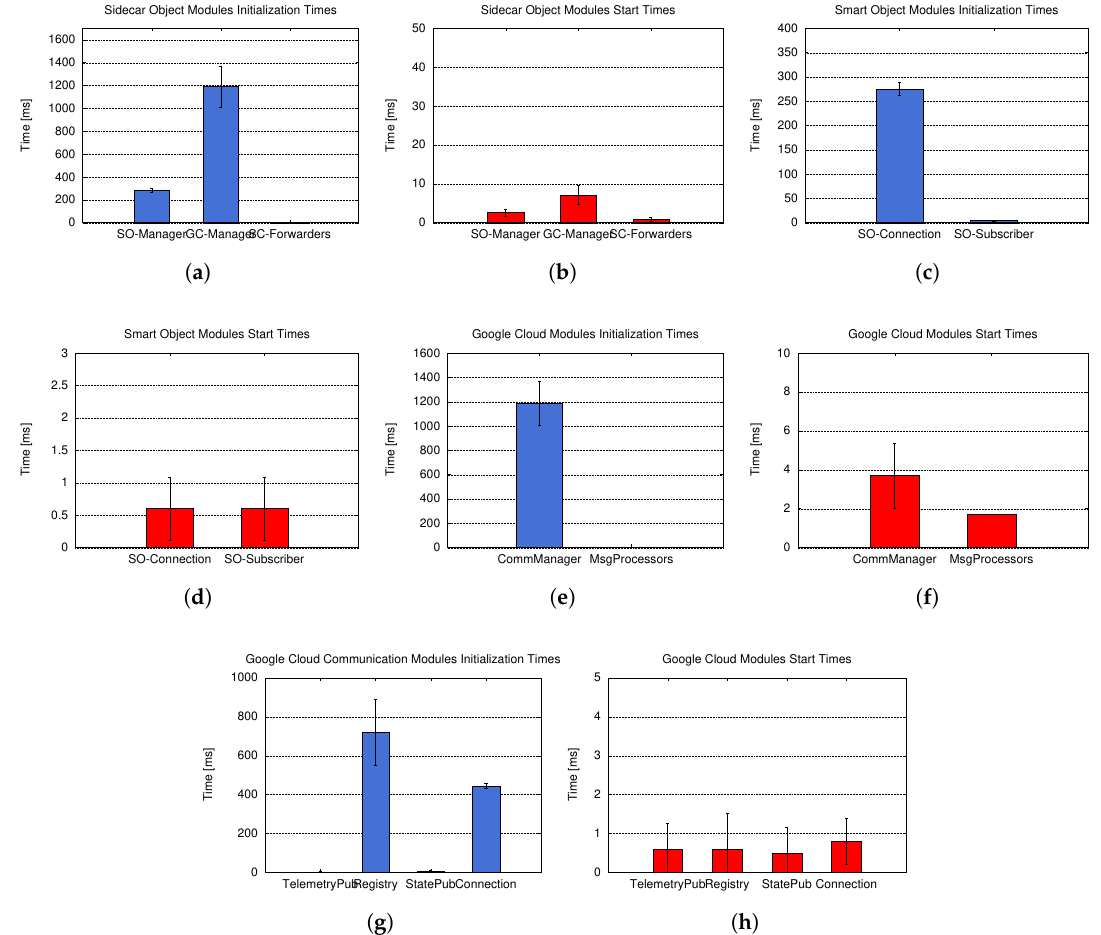
Figure 7. ( a ) Sidecar object modules initialization times; ( b ) sidecar object modules start times; ( c ) smart object modules initialization times; ( d ) smart object modules start times; ( e ) Google Cloud Modules initialization times; ( f ) Google Cloud Modules start times; ( g ) Google Cloud Communication Modules initialization times and ( h ) smart object modules start